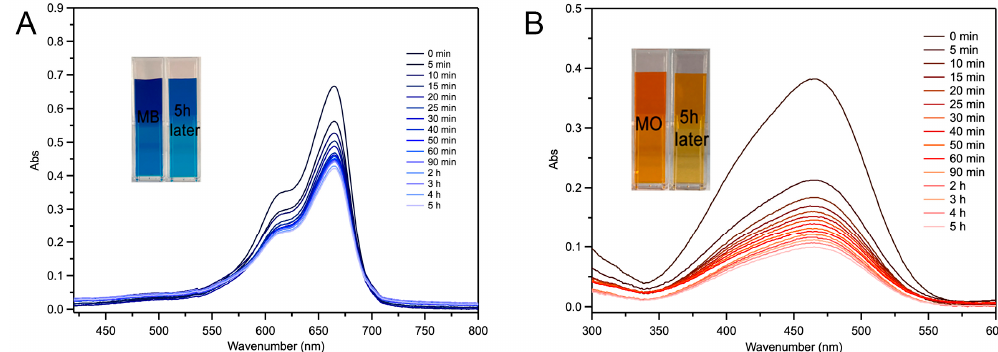
Figure 6. UV-Vis absorption spectra of ( A ) MB, ( B ) MO. Each sample was diluted 2.5 times before UV-Vis absorption spectra. The graph shows the color change before and 5 h after adsorption. Table 2. Comparison of absorption capacity of MB and MO by Fe-loaded MOF-545(Fe) and reported adsorbents .